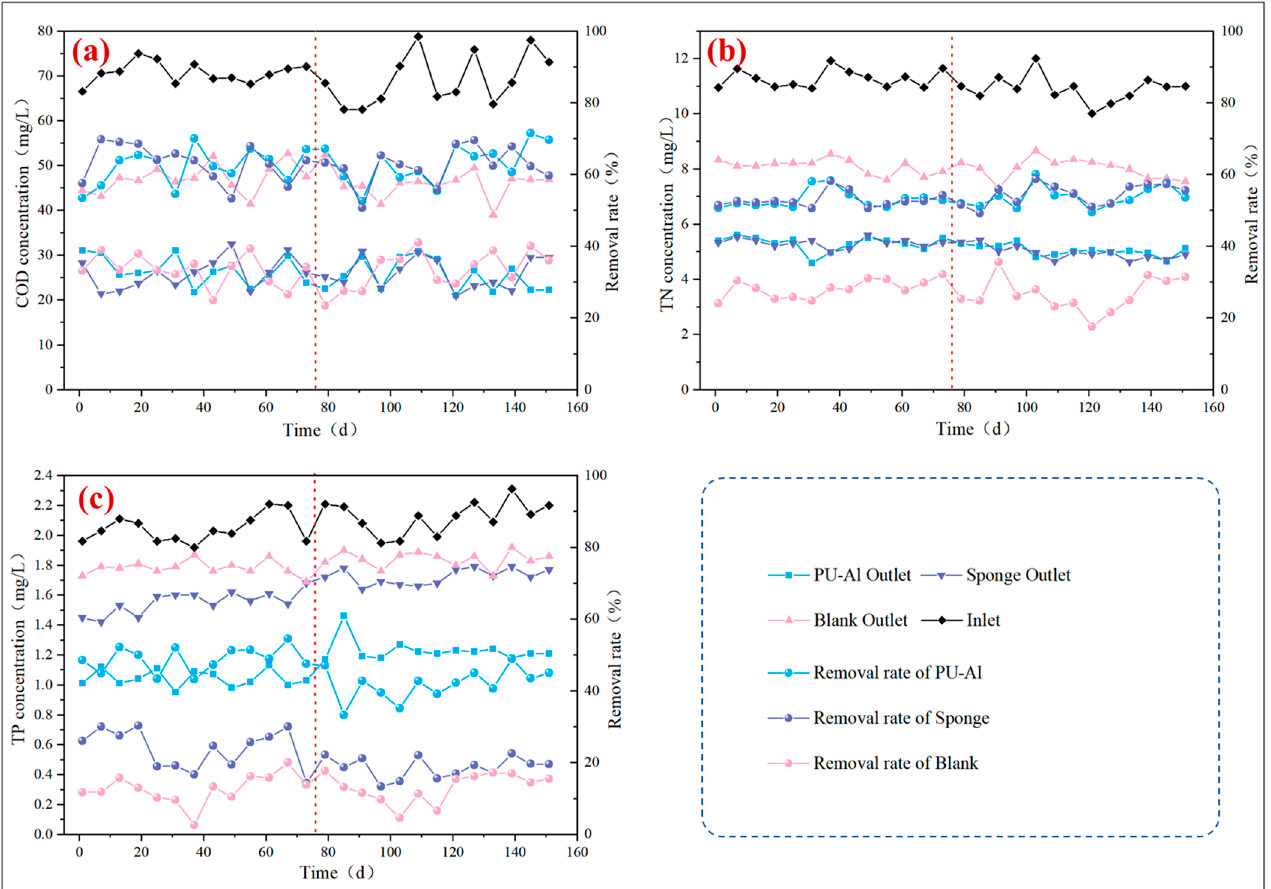
Figure 5. Pollutants removal performance in three FTWs. ( a ) COD removal performance; ( b ) TN removal performance; ( c ) TP removal performance.